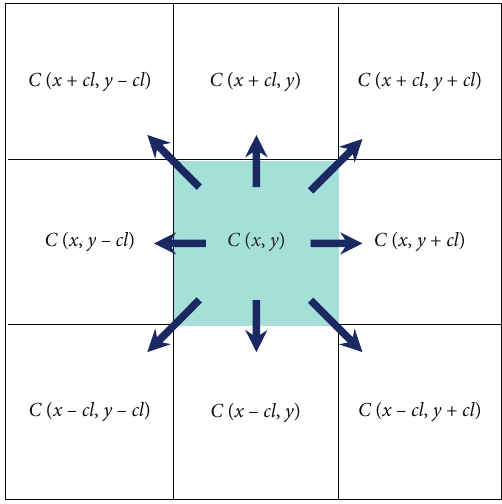
Figure 2: Moore neighborhood rule and direction transition probability. Figure 3: Diagram of an iterative process of evacuation individual j